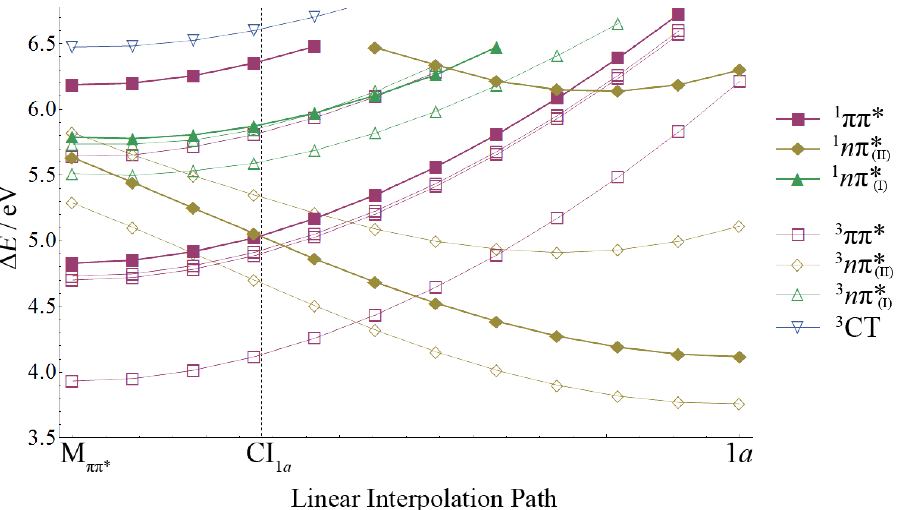
Figure 11. LIP constructed between M ππ ∗ and M a 1 geometries. Singlet (triplet) excited states are shown with filled (unfilled) symbols. The vertical line indicates the position of the 1 ππ ∗ / 1 n π ∗ Adiabatic states are color coded according to their